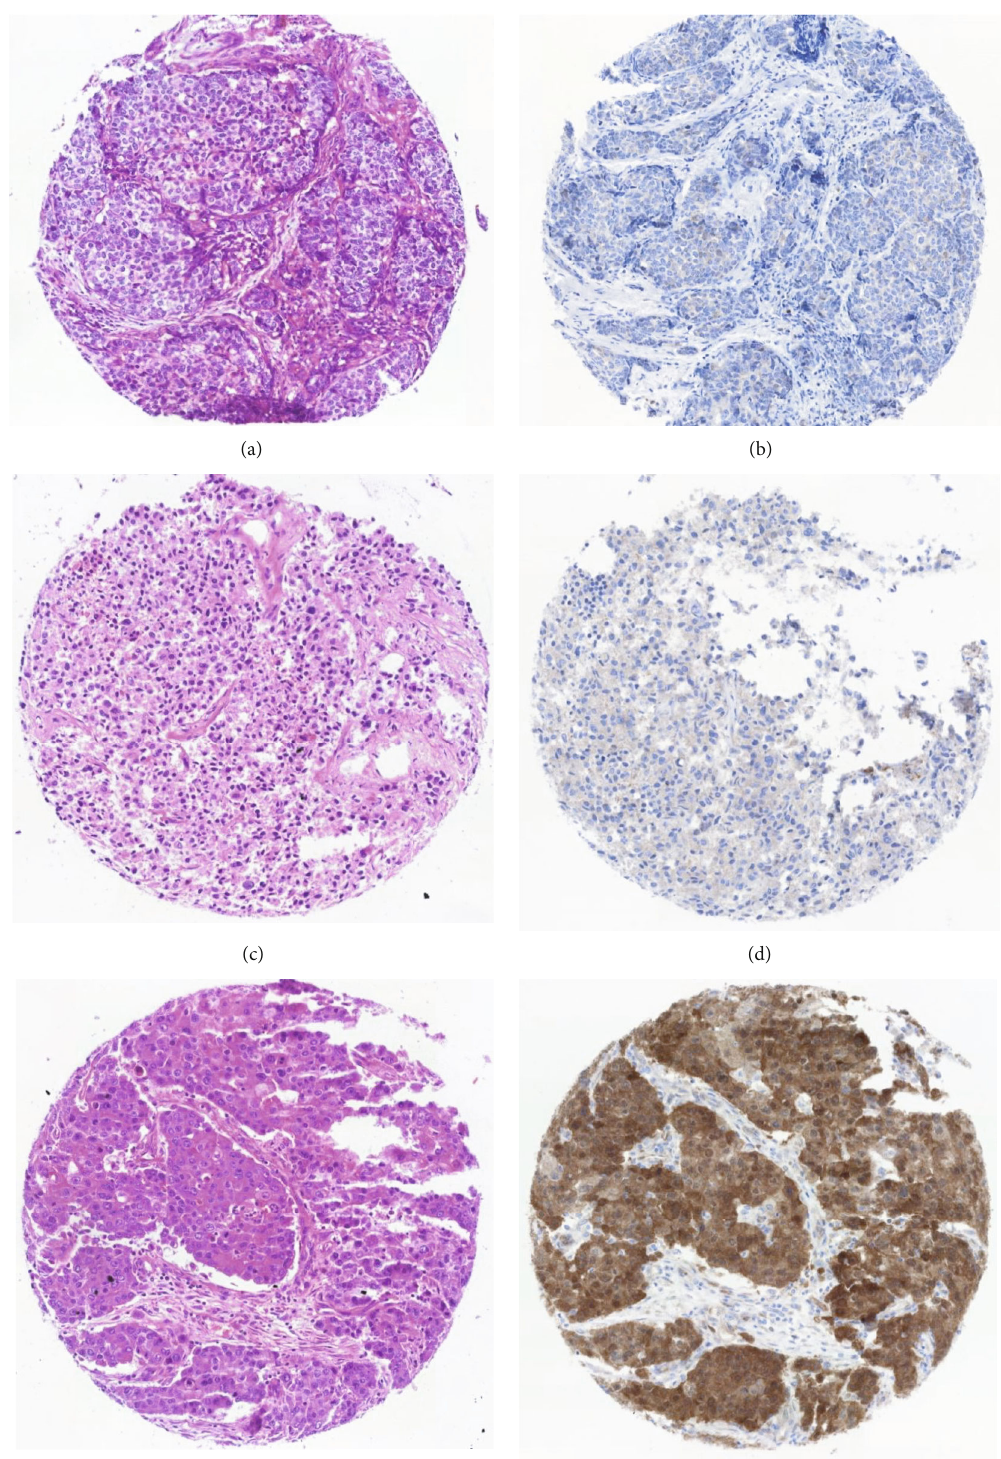
Figure 1: p16 immunostaining of HPV+ breast tumors with a representative HPV-negative/p16-negative breast tumor tissue. (a) H&E staining of the representative HPV-negative case. (b) Negative p16 immunostaining of the representative HPV-negative case. (c) H&E staining of the HPV39 and HPV6 dual-positive case. (d) Negative p16 immunostaining of the HPV39 and HPV6 dual-positive case. (e) H&E staining of the HPV16-positive case. (f) Strong, di ff use, nuclear, and cytoplasmic p16 immunostaining of the HPV16-positive